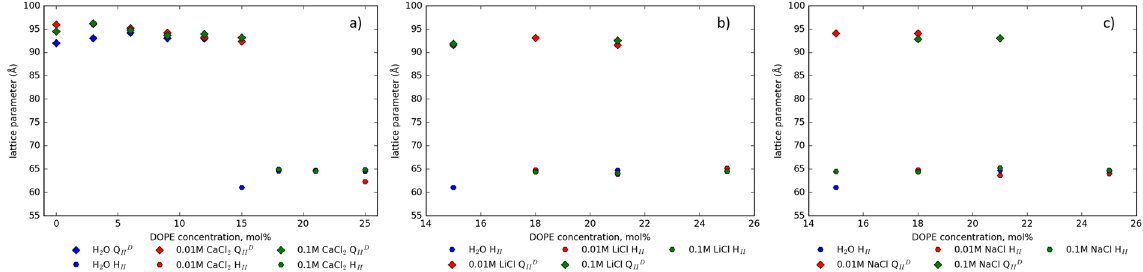
Figure 4. The effect of changing the hydrating salt cation in lipid systems of MO and DOPE. The effect of two concentrations - compared to water - of ( a ) CaCl 2 on the phase and lattice parameter of a MO:DOPE cubic phase; ( b ) LiCl on the phase and lattice parameter of a MO:DOPE cubic phase; ( c ) NaCl on the phase and lattice parameter of a MO: DOPE cubic phase. In the presence of Ca 2 + ions, Q IID phases of monoolein and DOPE show little variation in lattice parameter before a phase transition to H II . Upon hydration even with monovalent salt solutions, a complete Q IID to H II phase transition is put off until the dominant force in the system is the membrane Gaussian curvature, with the system demonstrating phase coexistence at 18 mol% and 21 mol%. 1D SAXS patterns for the data are in the Supplementary Information, Figures